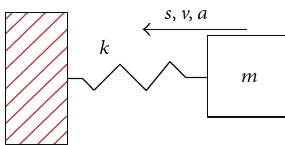
Figure 3: Elastoplastic